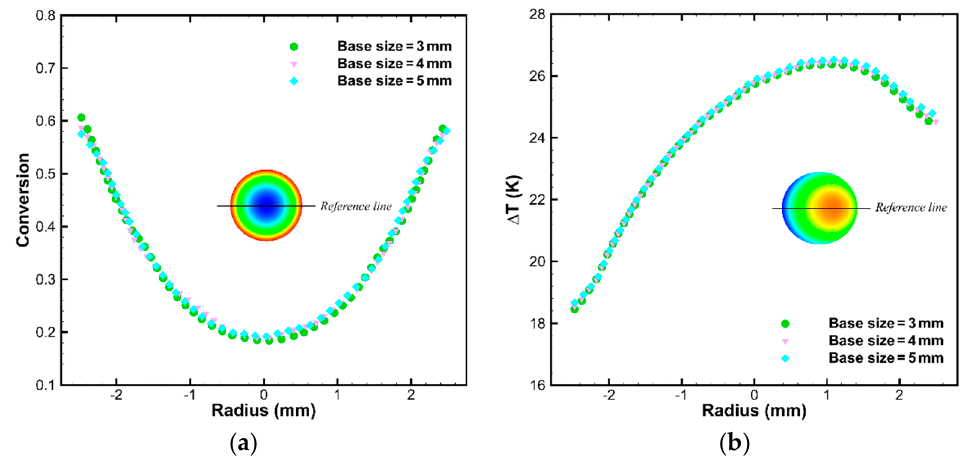
Figure 10. Grid independence test at various base sizes with a single OC particle: The profile of ( a ) conversion distribution and ( b ) reaction ∆ T distribution on the reference line at t = 50 s.